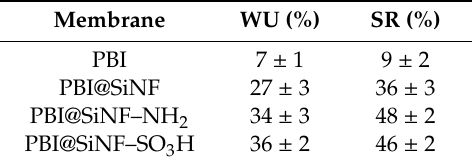
Table 1. Water uptake (WU) and swelling ratio (SR) values for the PBI composite membranes.